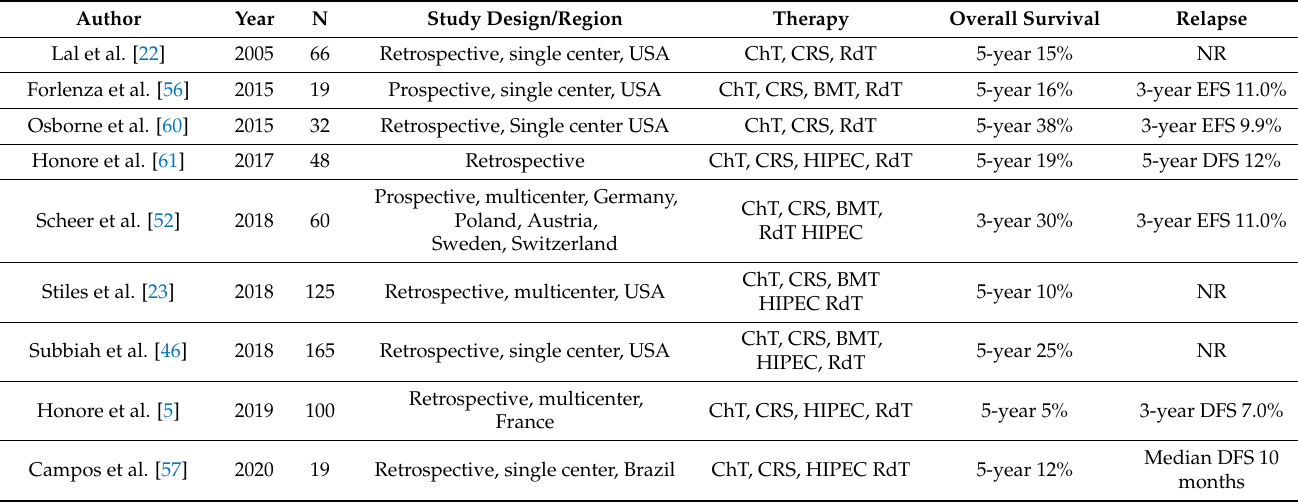
Table 2. Summary of studies with multimodal therapy for first-line treatment of patients with desmoplastic small round cell